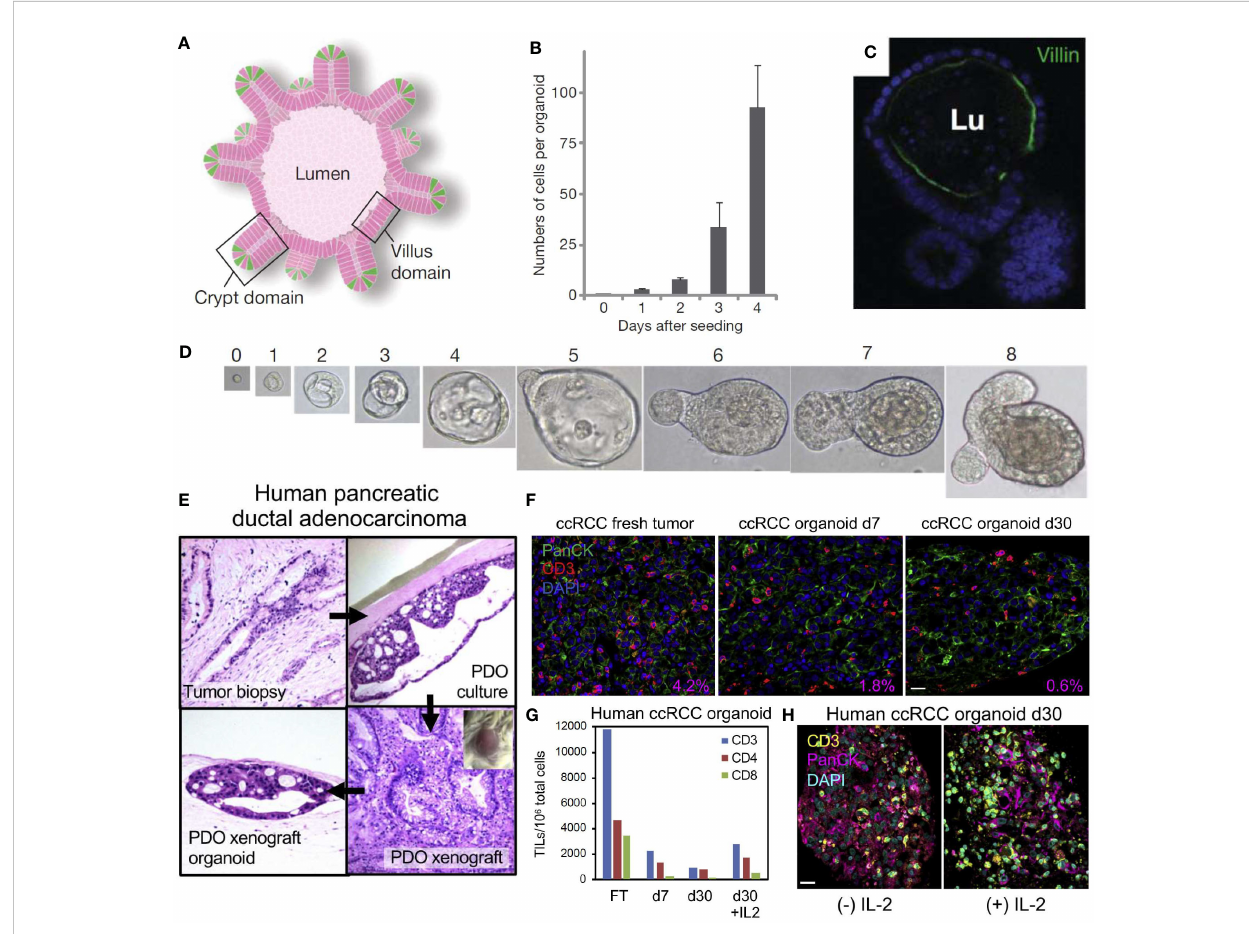
FIGURE 3 Self-organizing organoids derived from single stem cells, and the cellular composition of patient-derived organoid models of the tumor immune microenvironment. (A) Intestinal crypt organoid schematic showing villus-like epithelium lining the interior lumen (Lu), with crypt domains. (B) Average number of cells within crypt stem-cell derived organoids at 0-4 days after initial single-cell seeding. (C) Intestinal organoid confocal image showing villin in green (enterocytes) and nuclei in blue indicating that the organoid has formed a lumen and villus domain. (D) Growth from a single Lgr5-GFP hi crypt stem cell at Day 0-8. Panels (A – D) reproduced from Sato, et al. ( 87), Copyright 2009, with permission from Springer Nature Customer Service Center. (E) Demonstration of human pancreatic ductal adenocarcinoma (PDAC) patient-derived tumor organoid (PDTO, top right) cultured and xenografted to form a patient-derived tumor xenograft (bottom right) and re-derived as an organoid (bottom left). The original tumor ’ s histology (top left) has been recapitulated in the PDTO and the histology of the xenograft is preserved in the derived organoids. (F) Human clear cell renal cell carcinoma (ccRCC) PDTO in fresh tumor (Day 0), Day 7, and Day 30 with CD3 + tumor in fi ltrating lymphocytes (TIL) in red, PanCK in green, and nuclei in blue. The percentage area ratio of CD3 + cells in the lower right corner illustrates CD3 + cell content in fresh tumors and PDTOs. (G) Number of CD3, CD4, and CD8 TIL per 10 6 organoid cells from fresh tumor (FT) and representative ccRCC PDTO at Day 7, Day 30, and Day 30 + interleukin-2 (IL-2). (H) Day 30 ccRCC PDTO with (+) IL-2 (100 IU/mL) and without (-) IL-2 stained for CD3 in yellow, PanCK in magenta, and nuclei in blue. All scale bars are 20 m m. Panels (E – H) reprinted from Neal, et al. (88), Copyright 2018, with permission from